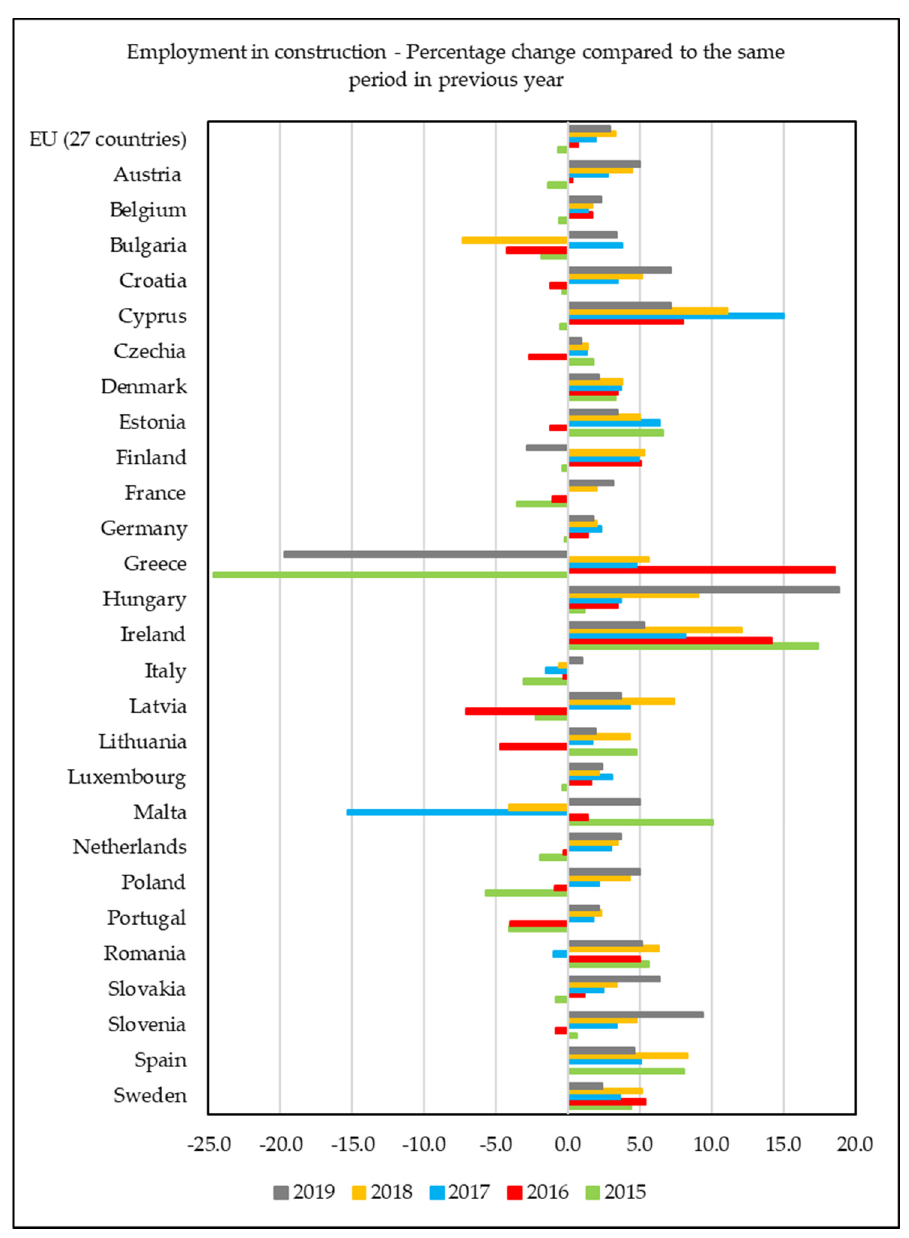
Figure 1. Employment in construction-Percentage change compared to the same period